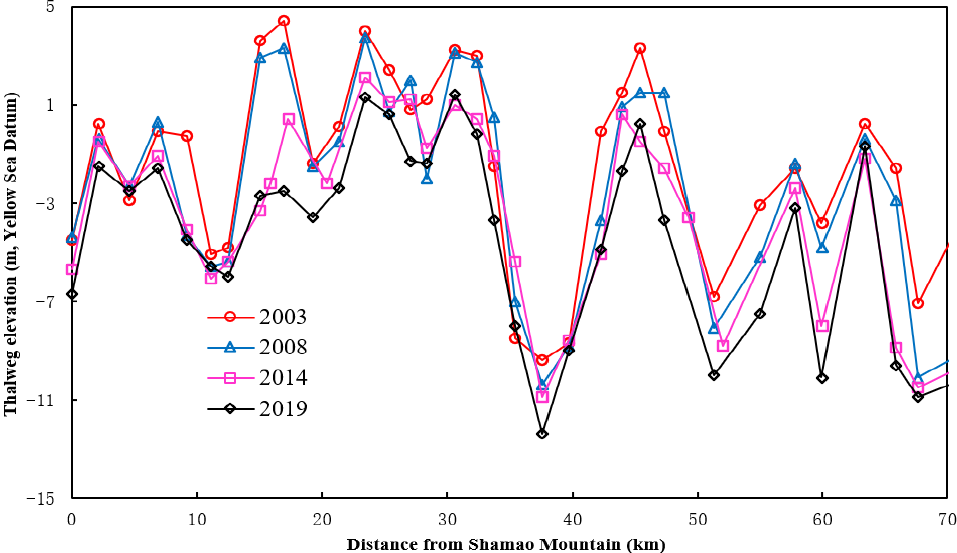
Figure 5. The thalweg longitudinal profile of the Wuhan reach in typical years.